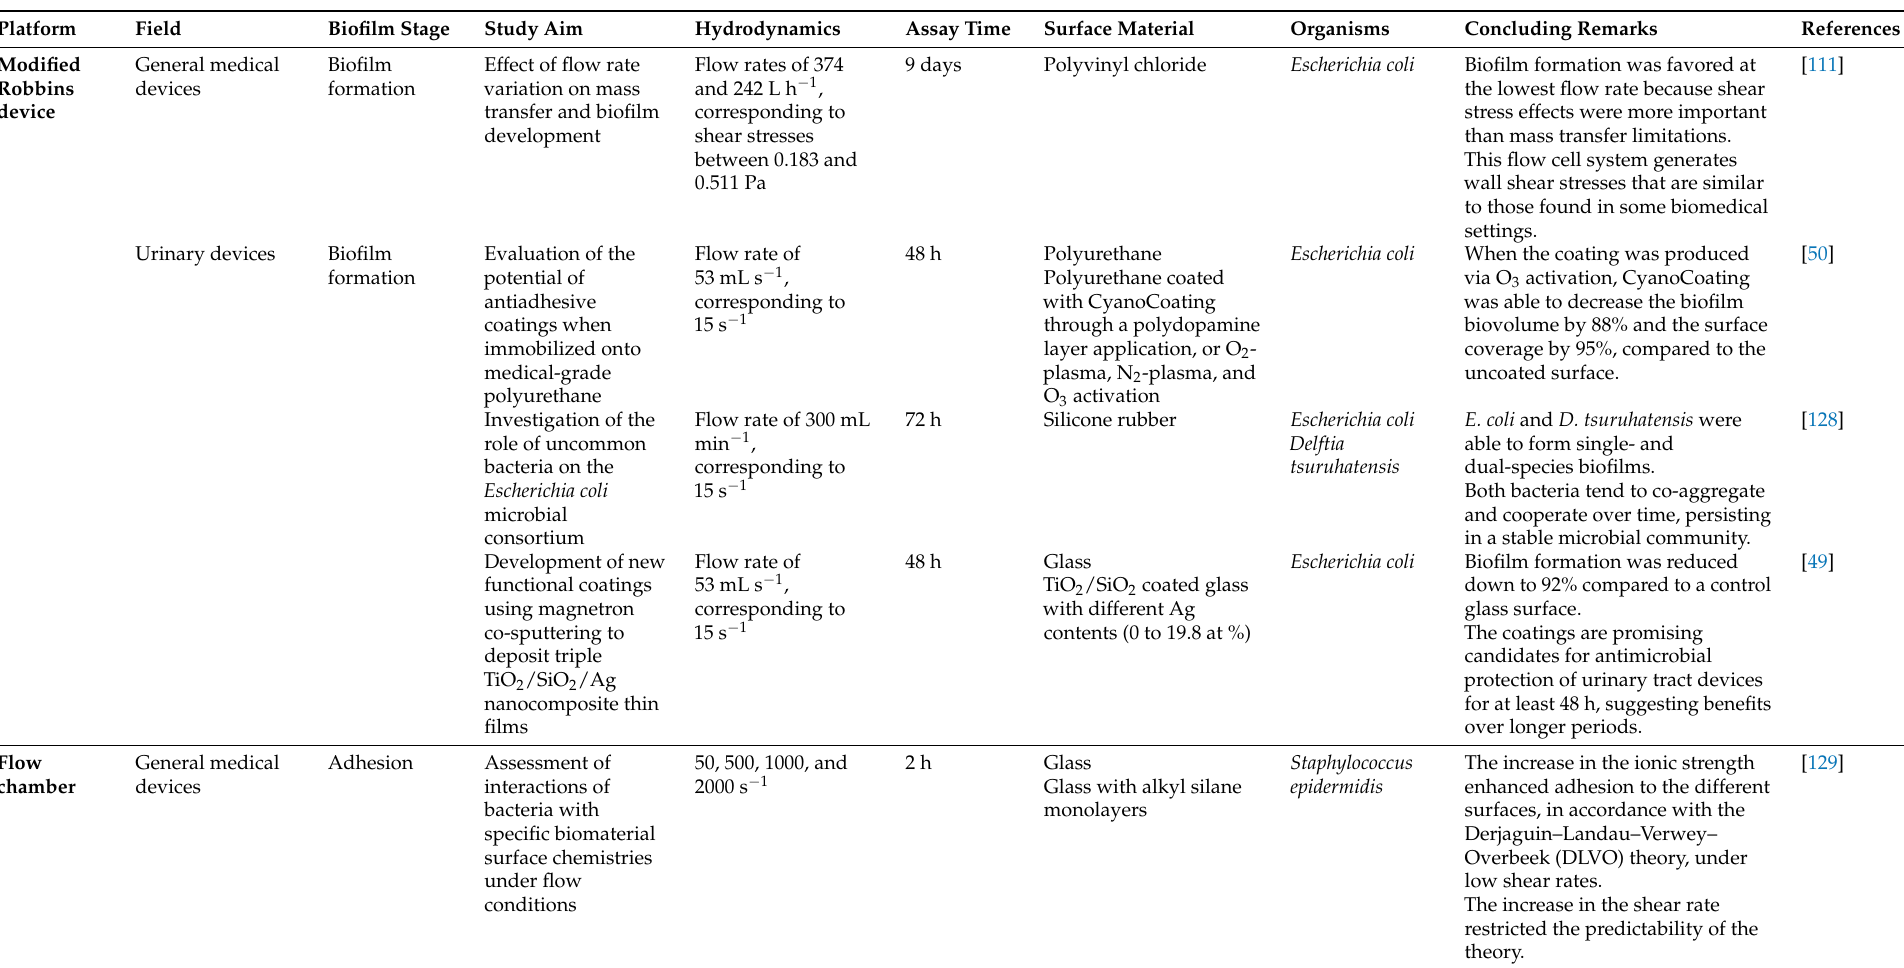
Table 7. Biomedical studies performed on different biofilm platforms to evaluate the initial adhesion, as well as the biofilm formation and treatment under the defined shear conditions.